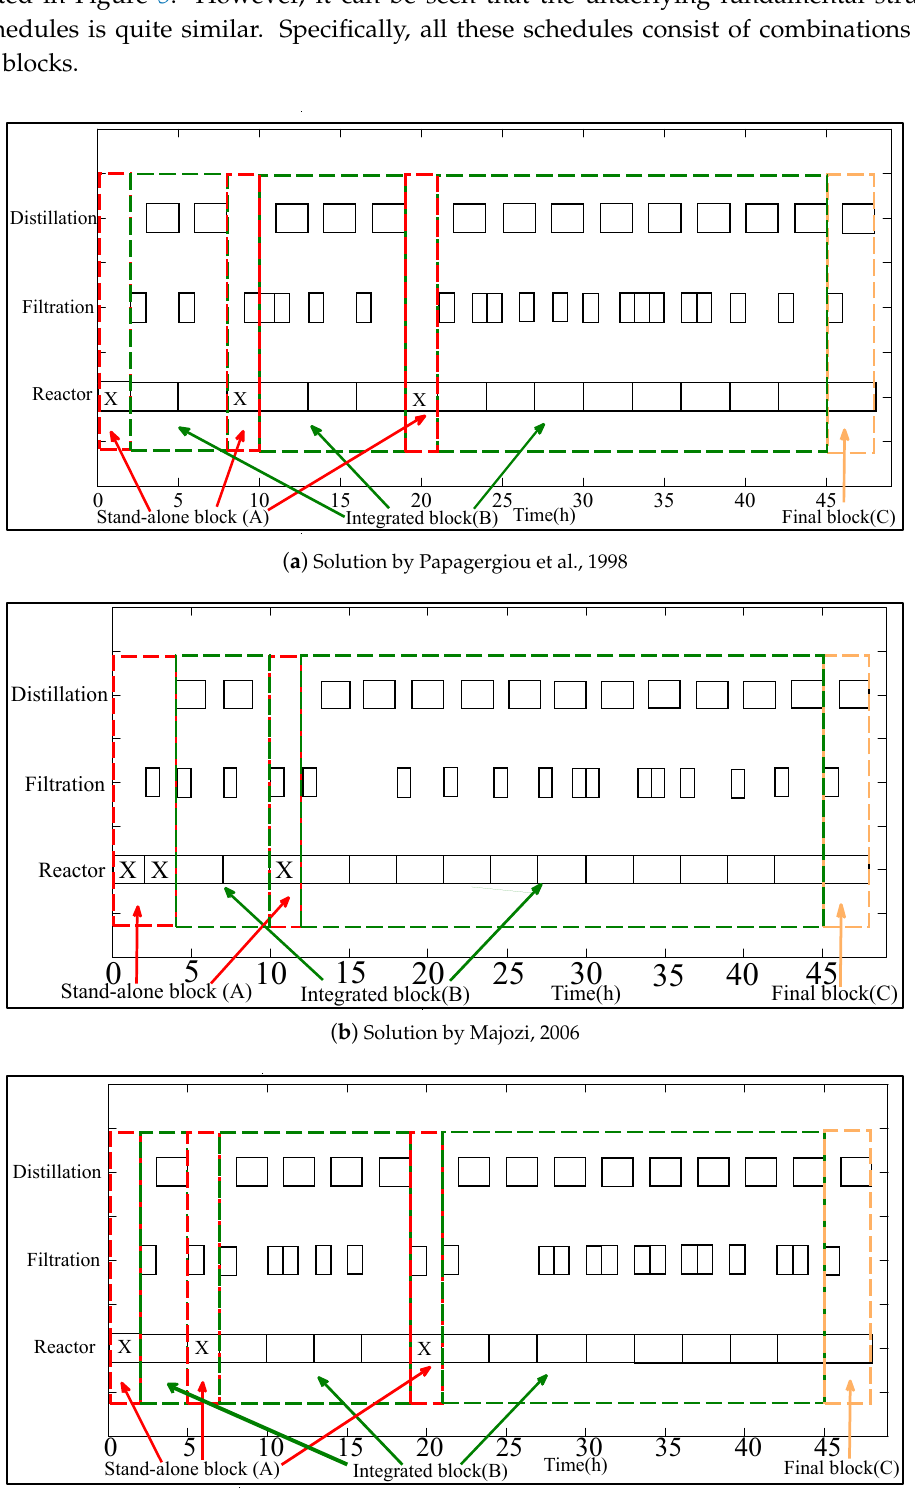
Figure 5. Optimal schedules for BR-S system (X, stand-alone